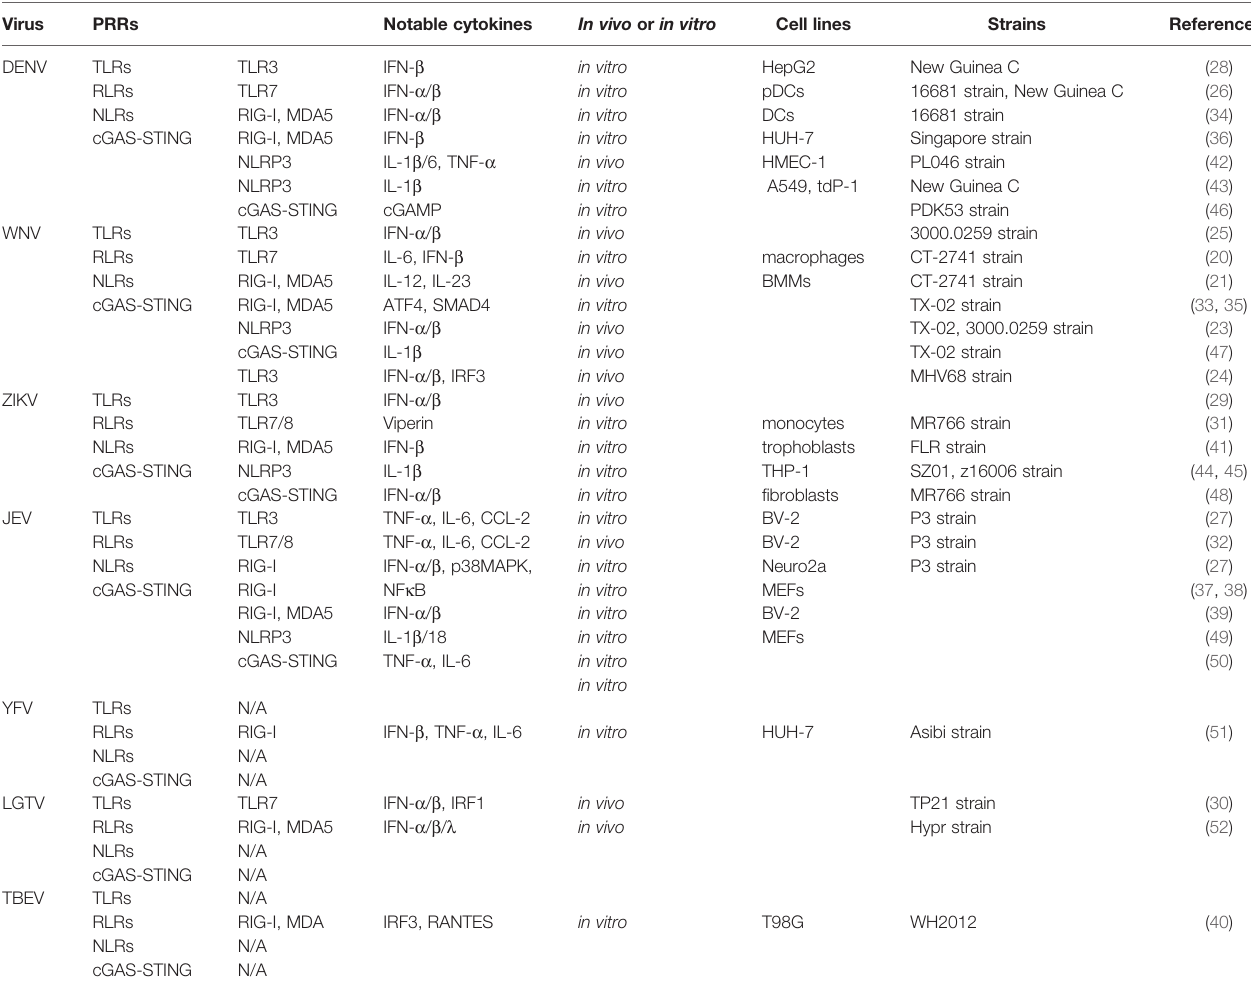
TABLE 1 | Engaged innate immune sensors and notable cytokines released in response to speci fi c fl avivirus a . Virus PRRs Notable cytokines In vivo or in vitro Cell lines